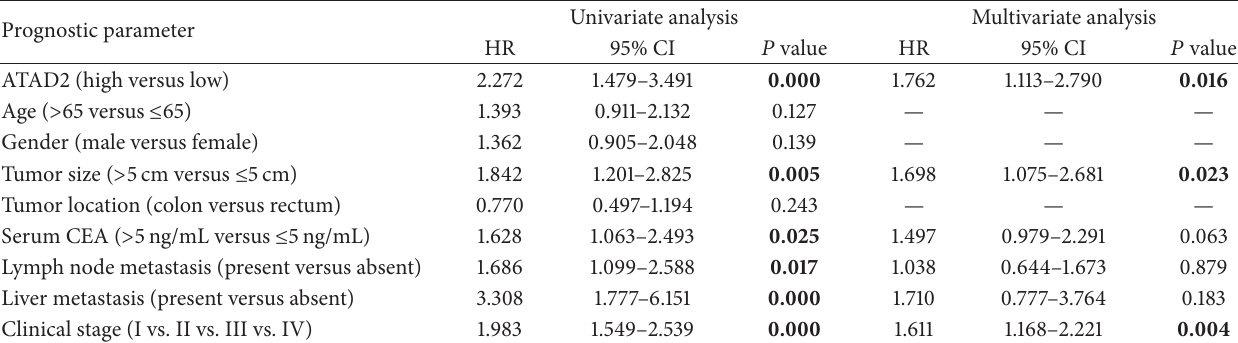
Table 2: Univariate and multivariate analyses showing the overall survival in colorectal